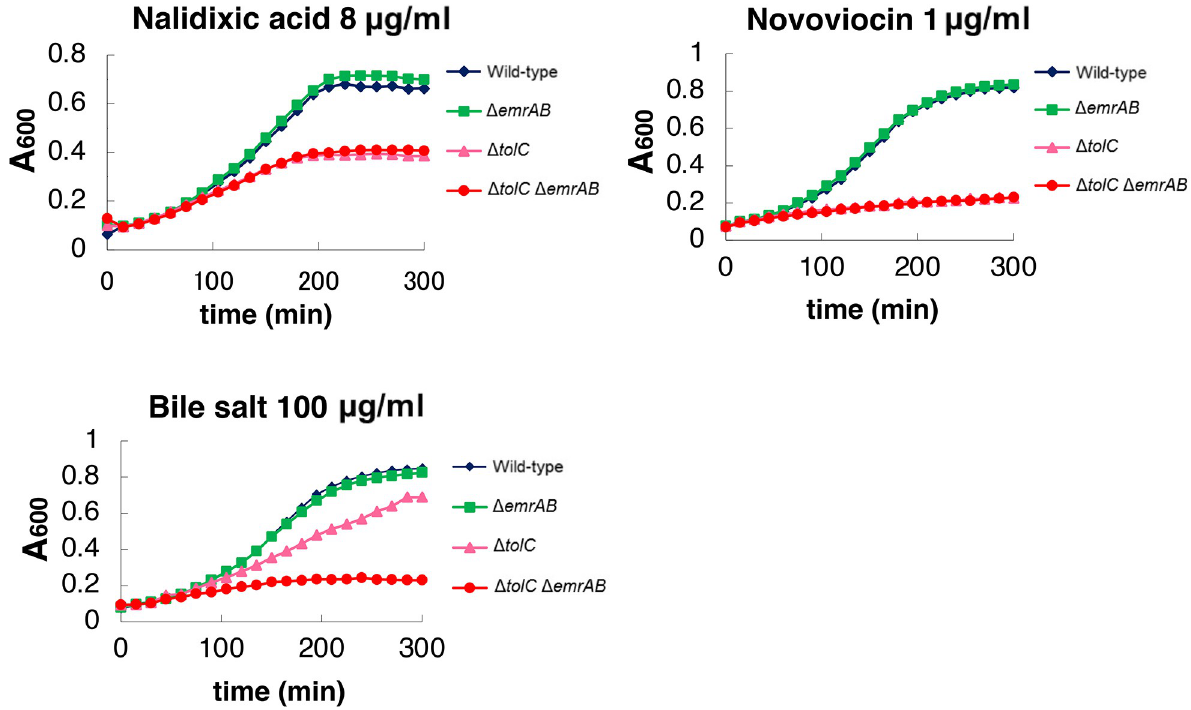
Fig 5. Different effect of the deletion of tolC and emrAB on the growth of S . enterica in presence of EmrAB substrates. Growth was measured in the presence of 1 μ g/ml nalidixic acid, 8 μ g/ml novobiocin, or 100 μ g/ml bile salt. Shown is the result of one of the three experiments, which gave similar results.